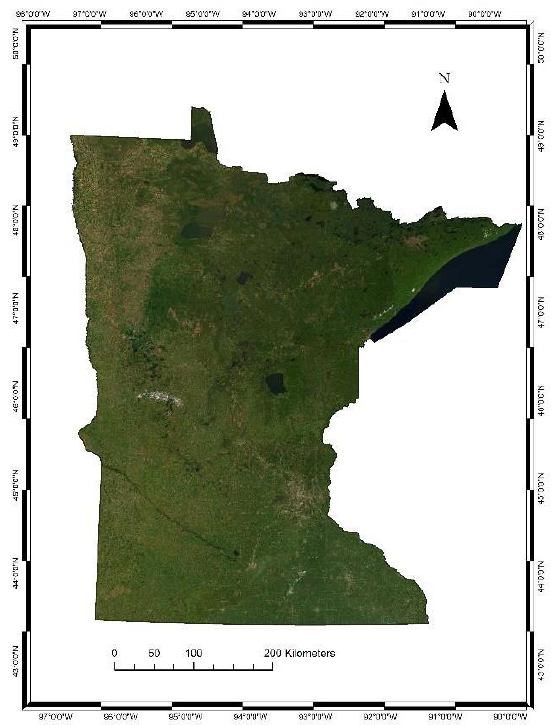
Figure 2. Study area Minnesota, US. Source Imagery is from